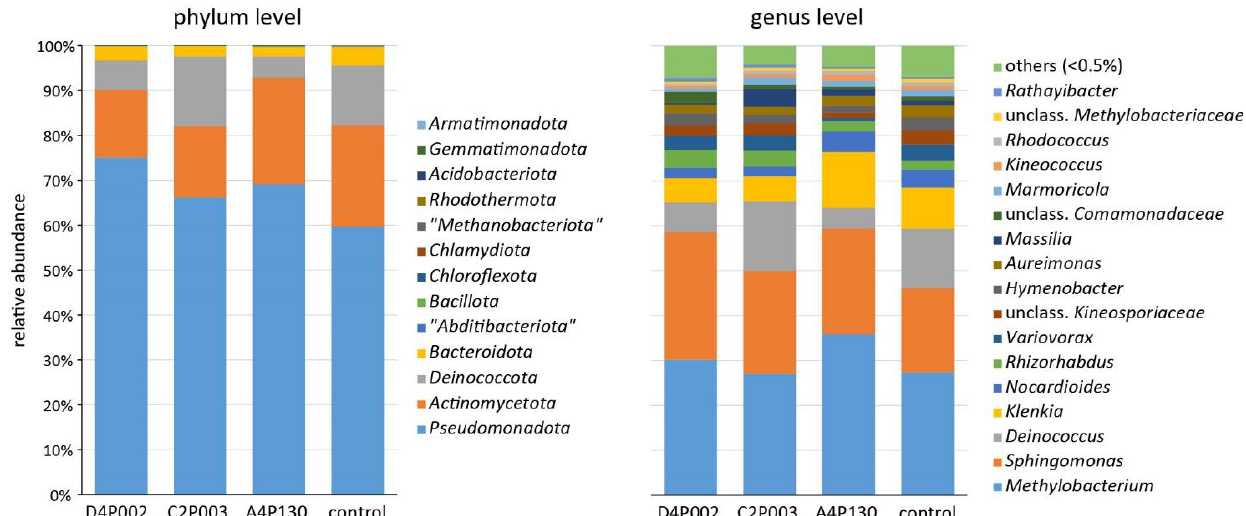
Figure 4. Impacts of inoculation with A. altamirensis C2P003, B. velezensis A4P130 and L. fraxinea D4P002 on ash seedlings. The effects on ash dieback were monitored by the health status of H. frax- ineus -infected seedlings. Health status and ash dieback symptoms were estimated as described by Peters et al. [80]. Bonitur scale: 1: healthy, 2: 10 – 25% leaf damage, 3: 26 – 60% leaf damage, 4: 61-99 leaf damage, 5: dead plants. Stars indicate significant differences compared to the control ( p < 0.05).